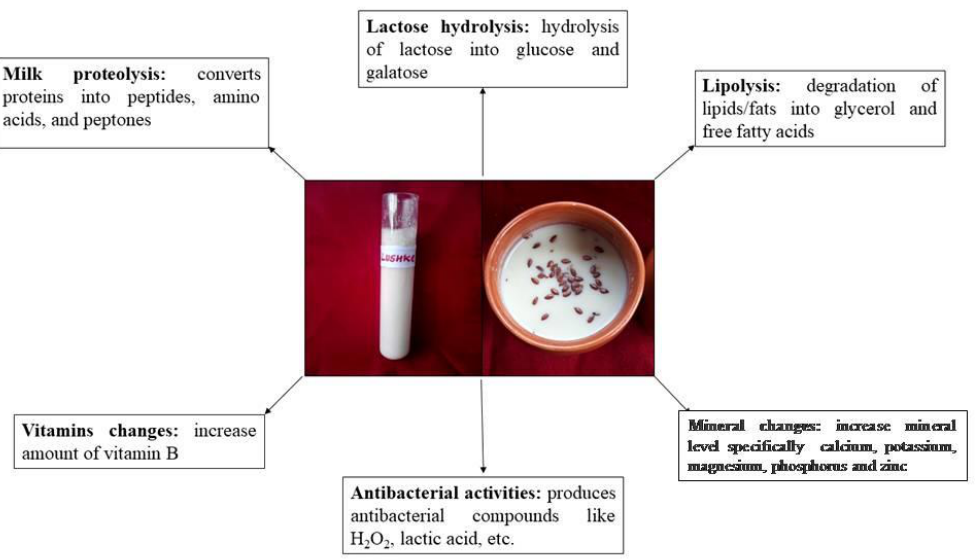
Figure 3. Changes in fermented dairy products during